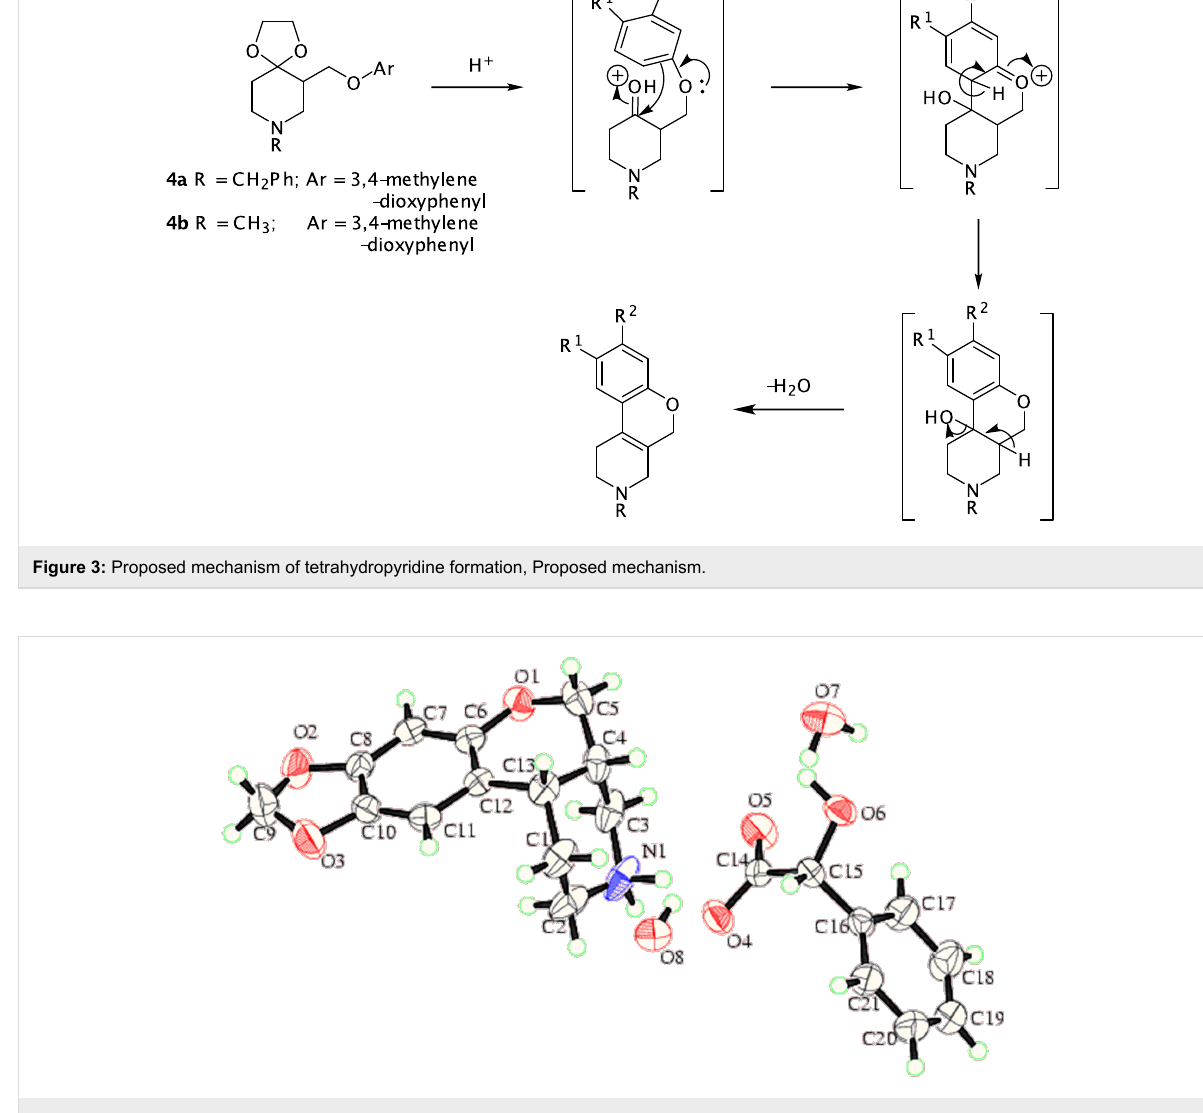
hydrogenation of N -benzylated benzopyranopyridine derivative 5a using 10% palladium on charcoal in a methanol-HCl mixture (Scheme 2). Initial hydrogenation experiments provided N -benzyl saturated pyridine derivative 8 and N -unsubstituted unsaturated product 6 . After extended reaction time, deben- zylated saturated product 7 was formed with the cis configura- tion. Compound 6 can be obtained by terminating the reaction after 4–6 hours followed by chromatographic purification of the crude. The enantiomers were separated by diastereomeric resol- ution using D -(-)-mandelic acid as the chiral agent. The abso- lute configuration of the mandelate salt of 7b was determined as S,S by X-ray diffraction analysis (Figure 4) (For details see also: Figure 4 and Supporting Information File